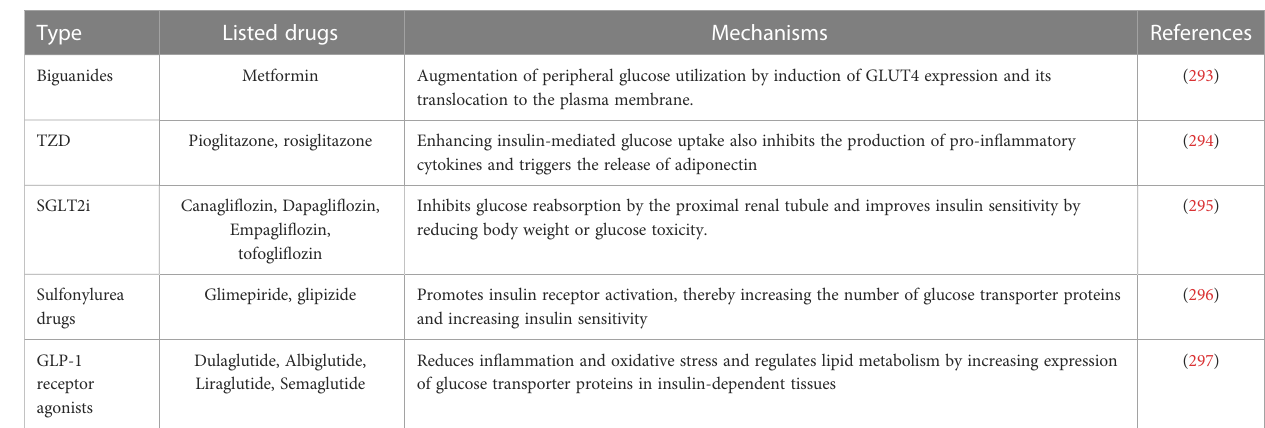
TABLE 1 Clinically used antihyperglycemic drugs to improve